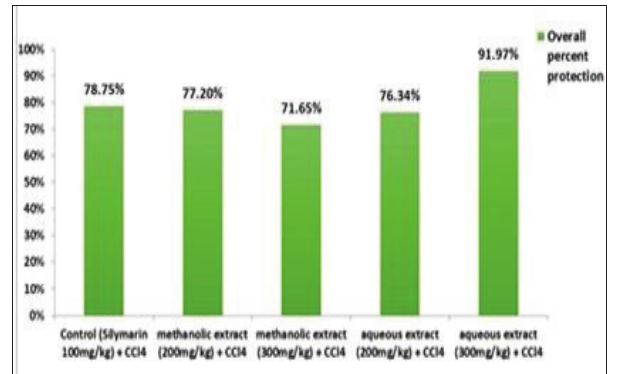
Fig-3: Effects of T. dioica extract on hepatic cells